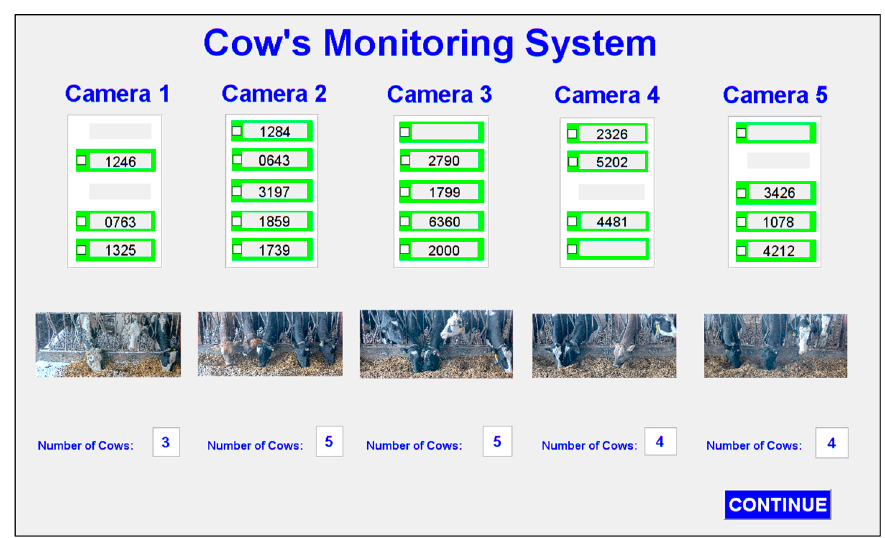
Figure 21. Finished process view of the system.